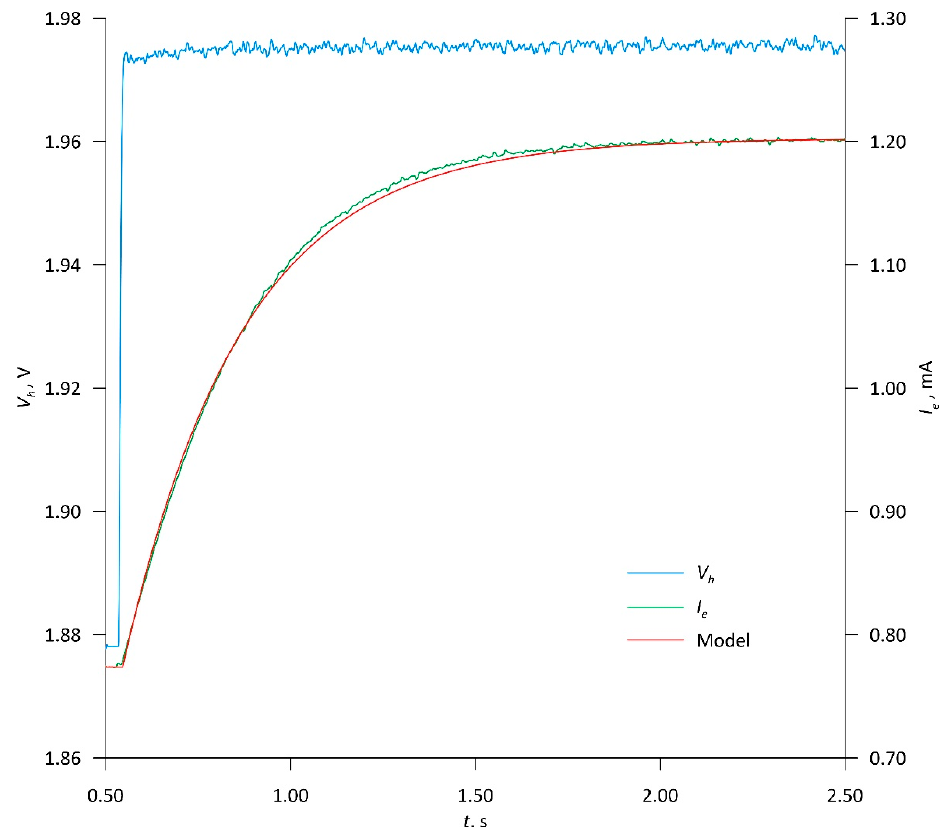
Figure 5. Emission current step response and the step response of the first-order inertial model with a delay, for thoriated tungsten cathode with dimensions d = 0.00012 m and l = 0.045 m, sensing resistors R 1 = R 2 = 0.383 Ω , sampling period T s = 1 ms, and anode voltage V a = 100 V. nent V h0 and the step voltage Δ V h = 0.05·V h0 . The values of the time constant T c and the delay time T 0 determined on the basis of these waveforms are presented as a function of the intensity of the emission current in Figure 6.